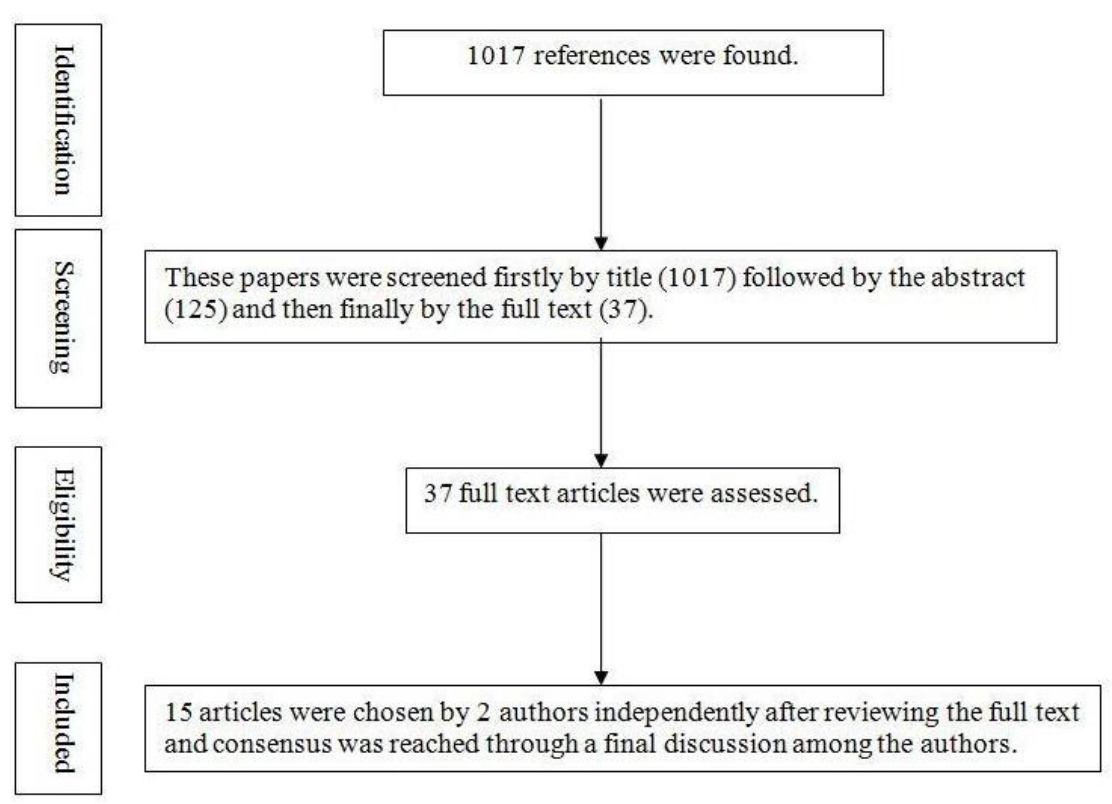
Figure 1. Flow chart of identification, screening, eligibility assessment, and final inclusion of number of